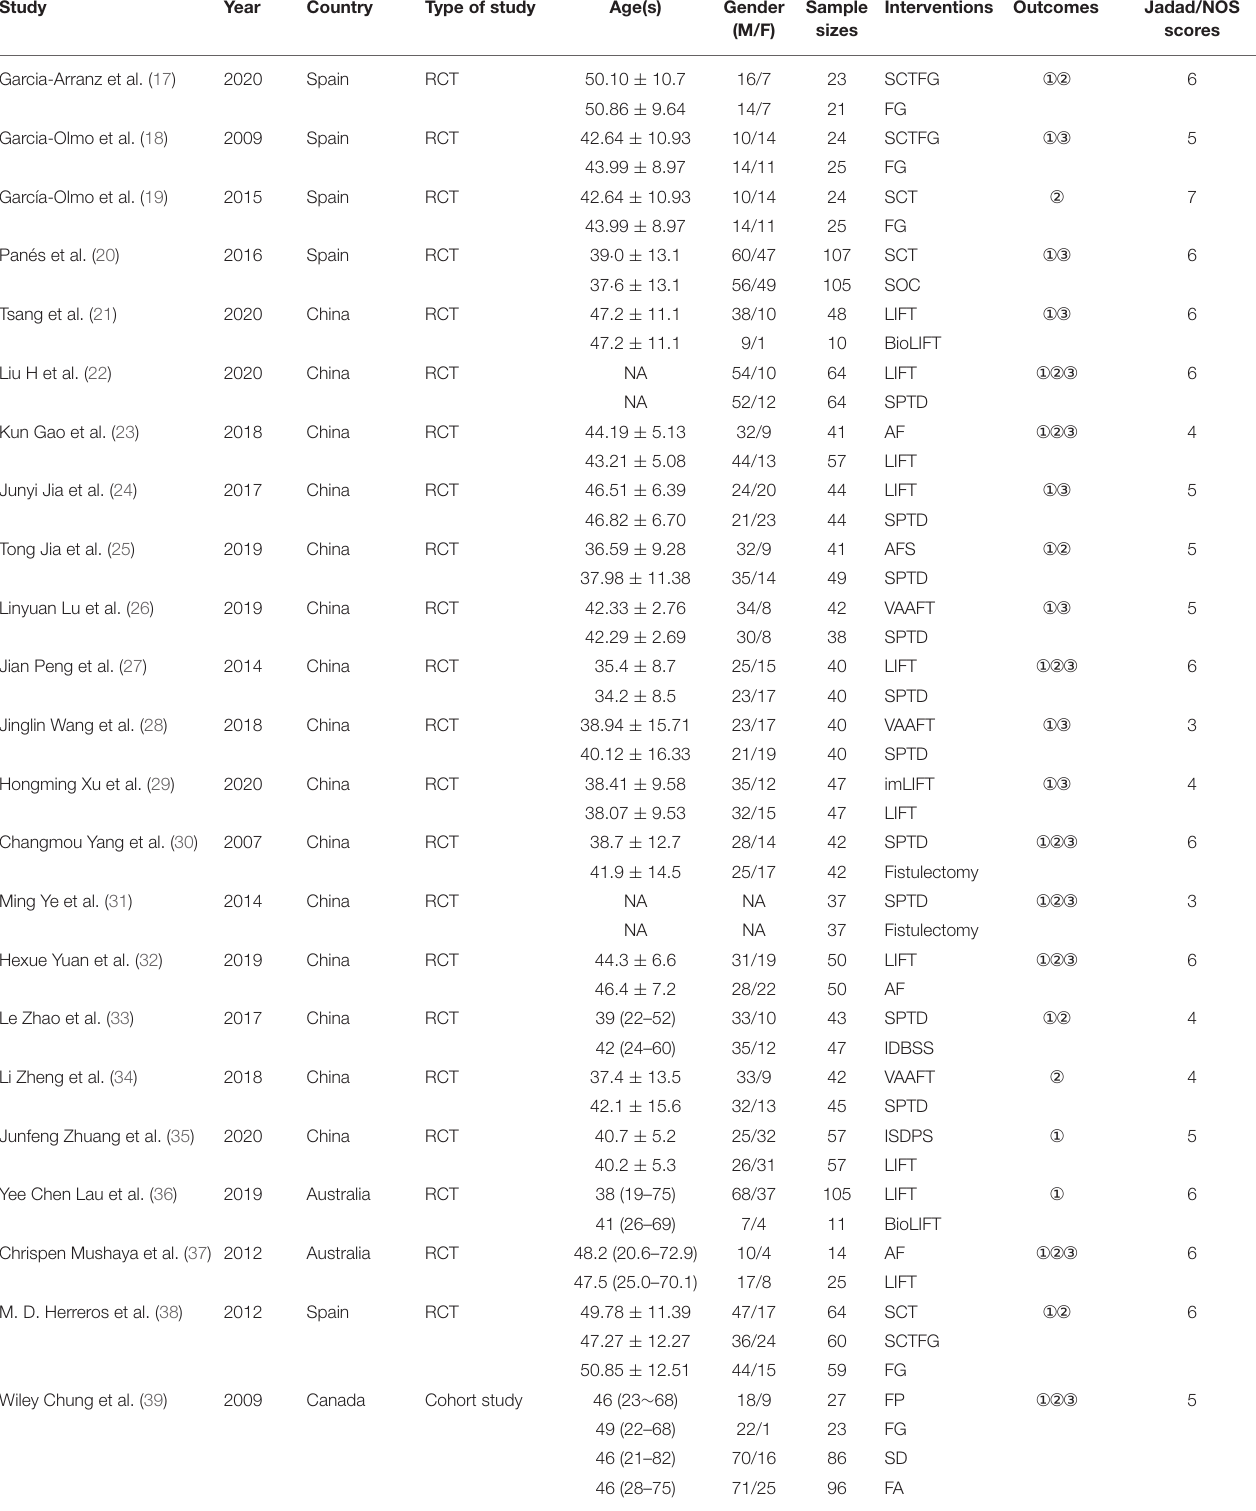
TABLE 1 | Basic characteristics and quality evaluation of the included studies. Study Year Country Type of study Age(s) Gender